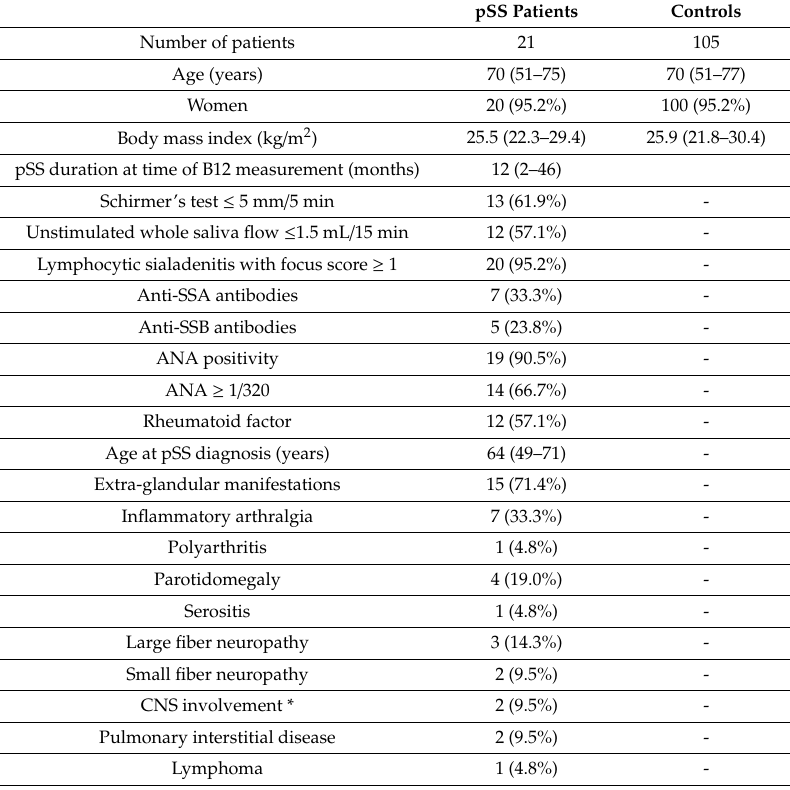
Table 1. Description of the study